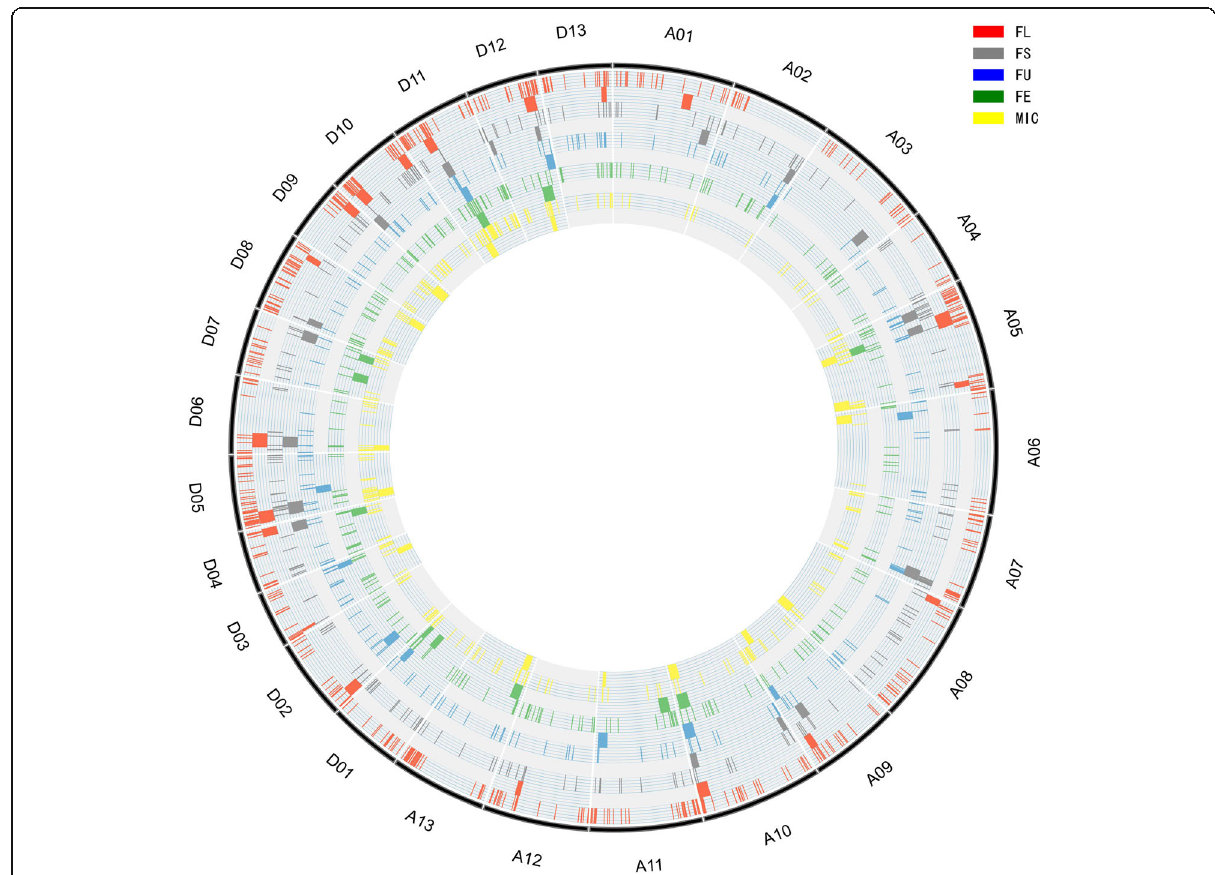
Fig. 2 Locations of Meta-QTLs and significant SNPs. Each color represents one trait, red for FL, gray for FS, blue for FU, green for FE, and yellow for MIC. There are two tracks for each trait, the inner tracks represent the meta-QTLs, and the outer tracks represent significant SNP loci associated with corresponding traits. FL, fiber length; FS, fiber strength; MIC, micronaire; FU, fiber uniformity; FE, fiber